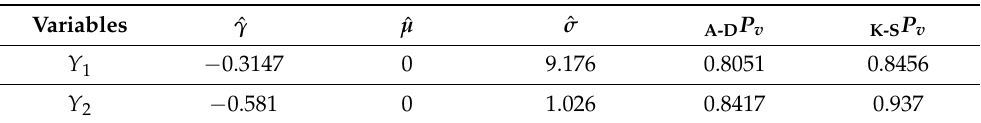
Table 1. Values of the estimators of exceedance H γ , µ , σ distribution parameters together with the results of compliance